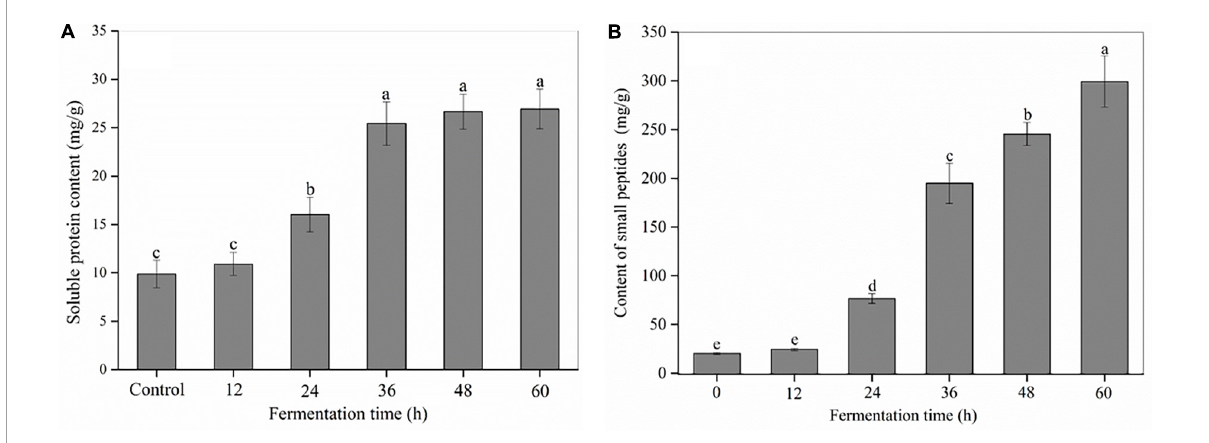
FIGURE2 The content of soluble proteins and small peptides in soybeans during the SSF. (A) Soluble proteins; (B) small peptides. p < 0.05 was considered as the significant level. The small letters were used to show the significant difference between samples at different fermentation